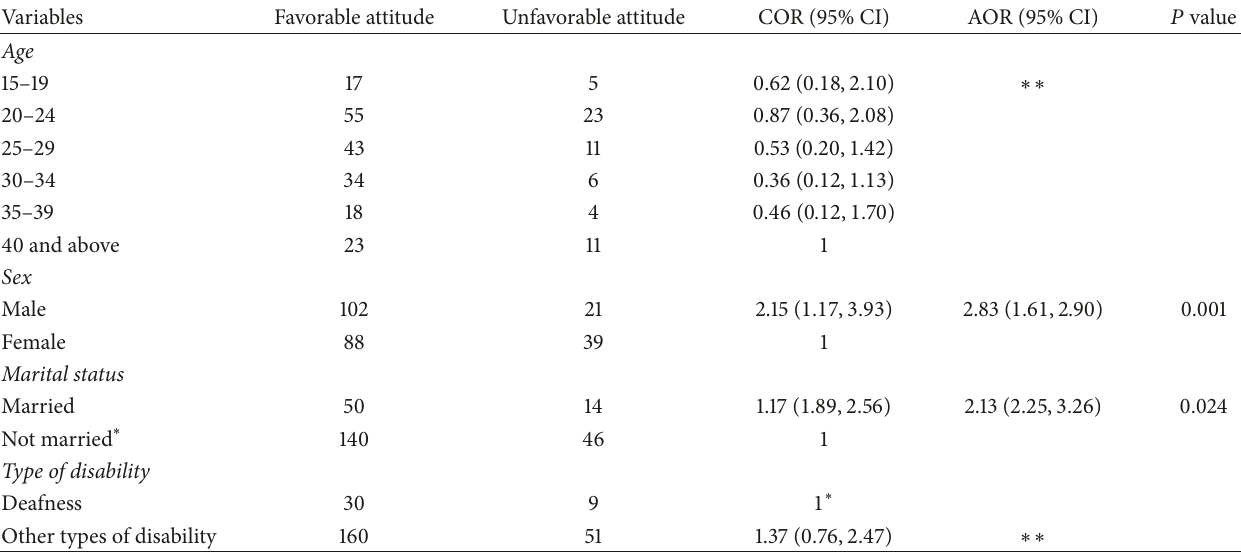
Table 5: Bivariate and multivariate analyses of factors associated with attitude towards HIV/AIDS among disabled people in Hawassa city, southern Ethiopia ( 𝑛 = 250